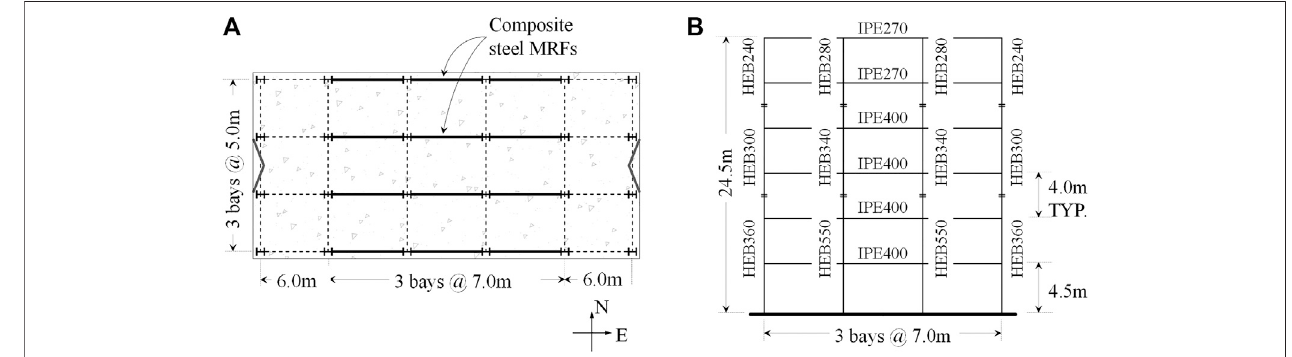
Frontiers in Built Environment |